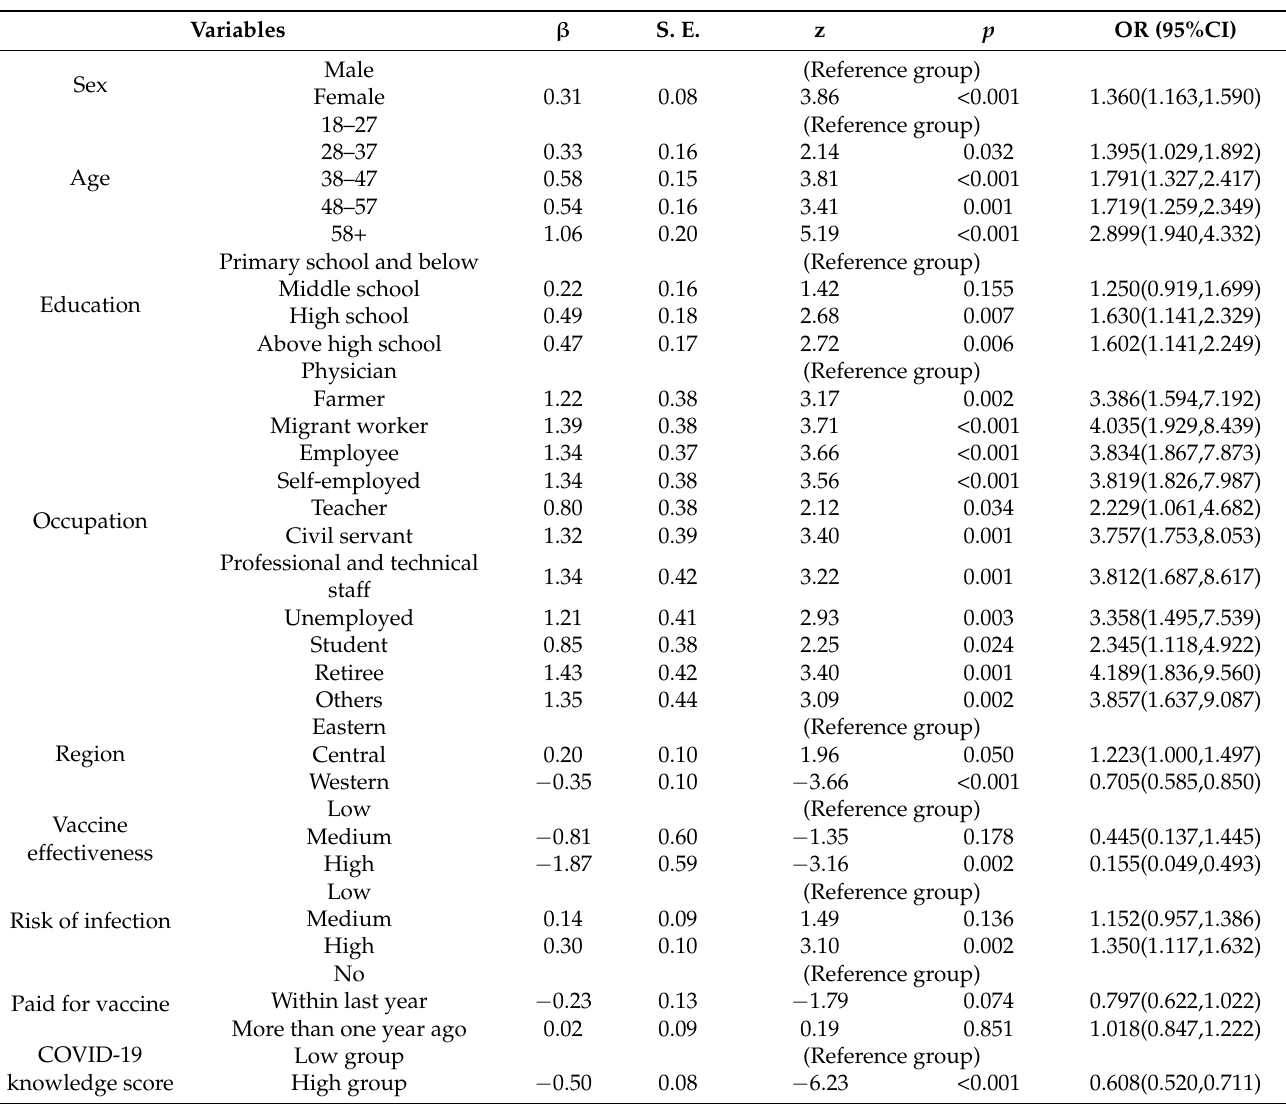
Table 4. Multivariate ordered logistic